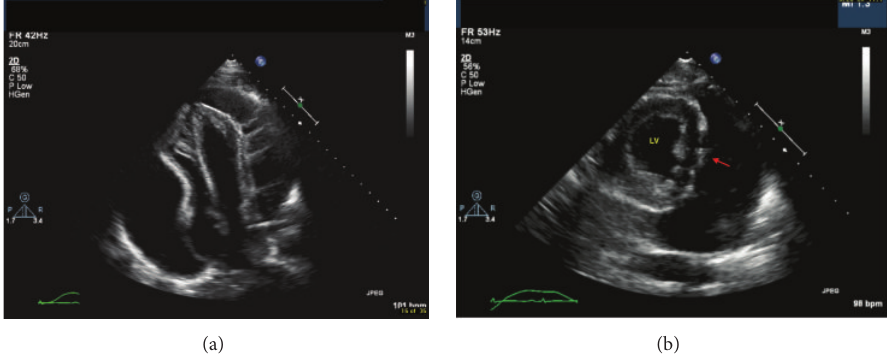
Figure 2: (a) Apical 4-chamber view on transthoracic echocardiogram showing large circumferential pericardial effusion with right atrial and ventricular compression. (b) Parasternal long-axis echocardiographic view of the left ventricle showing straightening of the LV lateral wall in diastole (red